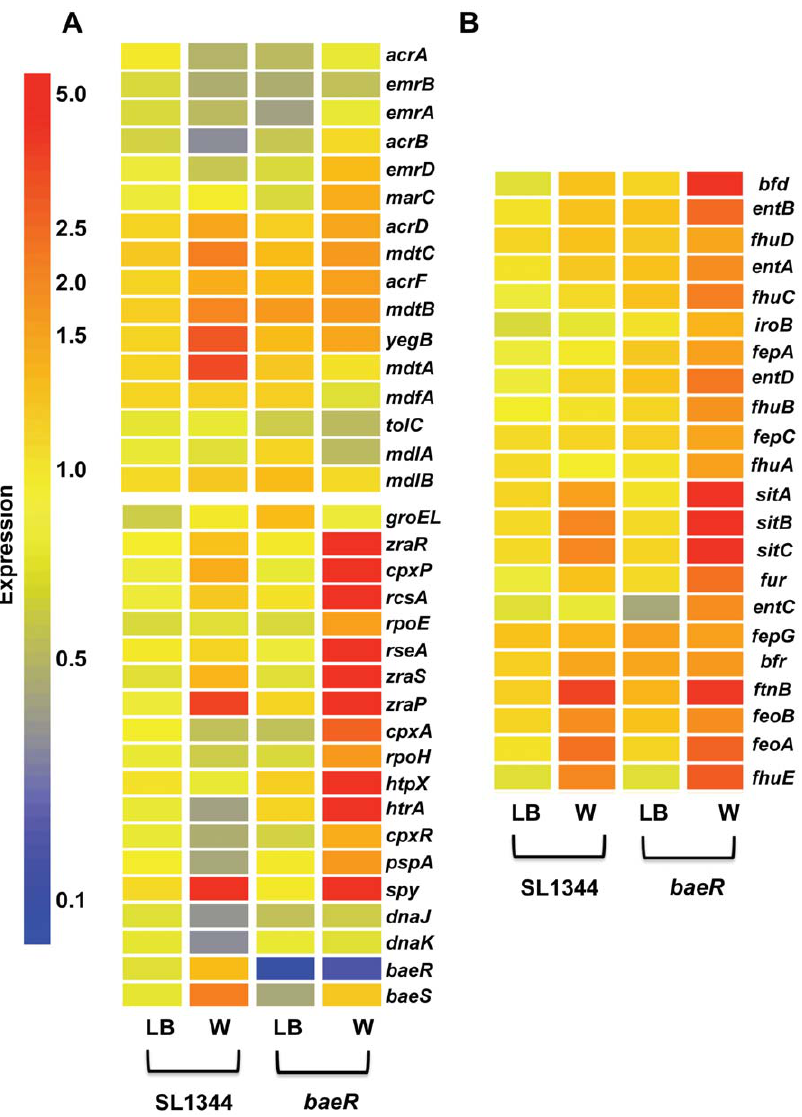
Figure 7. Heat map representing the expression level of selected genes of Salmonella wild type and baeR mutant in LB + / 2 20mM sodium tungstate. Panel A: genes involved in the transport and detoxification of metals and antibiotics (top panel) and genes involved in the response to stress, mainly envelope stress (bottom panel). Panel B: genes involved in the regulation and transport of iron and in the synthesis and transport of